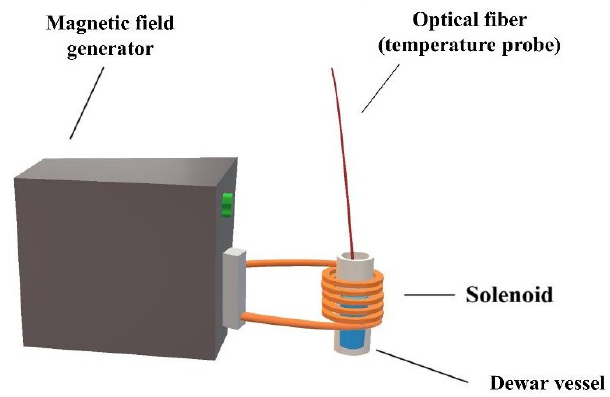
Figure 1. Schematic representation of the experimental setup used during hyperthermia tests.